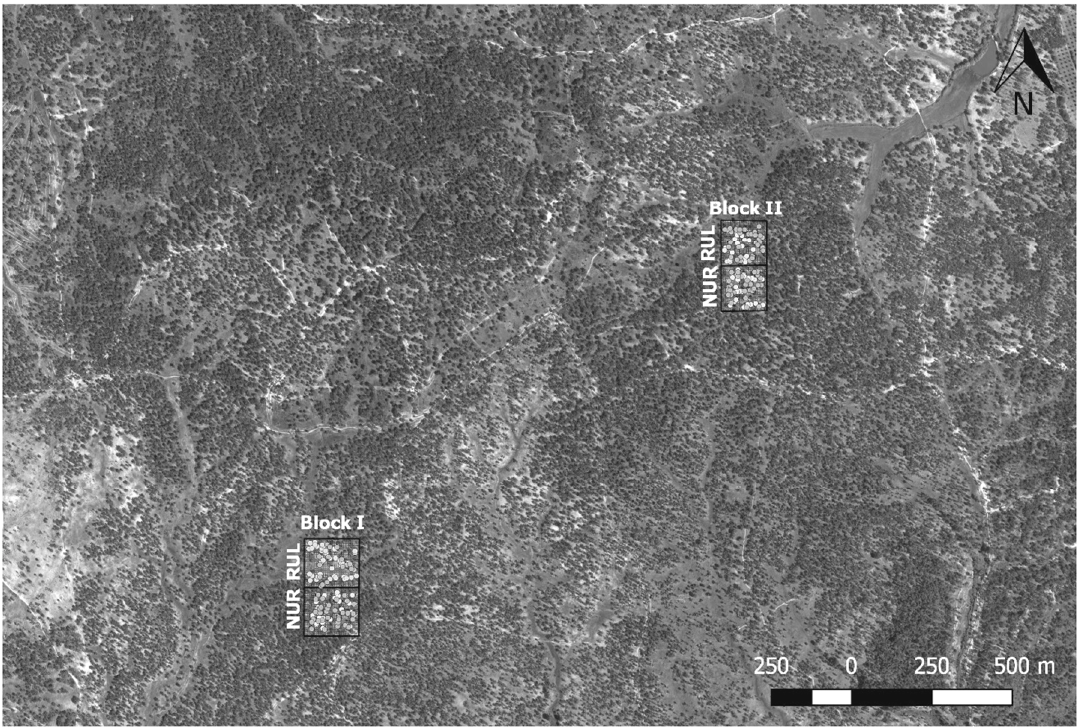
Figure 1. Sampling design and its organization into blocks and plots with tree distribution differentiated by cork rotation cycle—lighter circles are trees debarked in 2003 and 2012, darker circles are trees debarked in 2006 and 2015—where RUL represents the understory removal followed by periodic lupine seeding and NUR represents the maintenance of spontaneous understory vegetation.